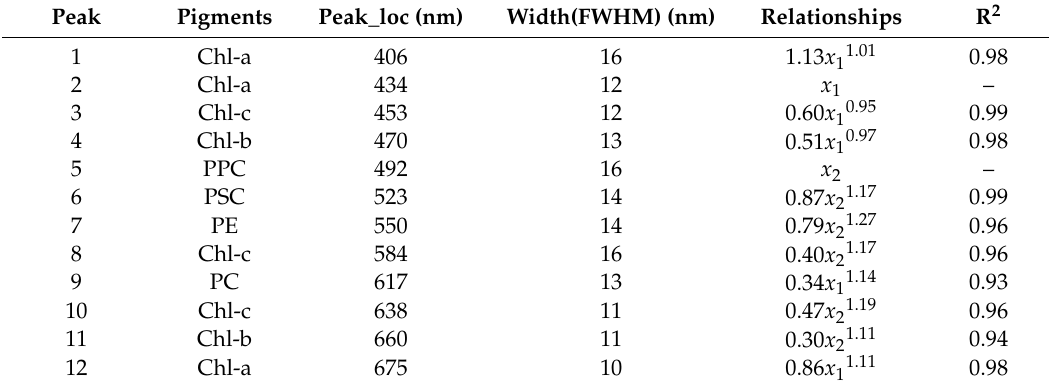
Table 2. The 12 Gaussian curves corresponding to the phytoplankton pigment absorption coefficients, with Peak_loc as the center location of each pigment absorption peak and width as the full width at half maximum (FWHM). The relationships indicate the power-law relationships used to estimate the Gaussian peak amplitudes from the two independent variables: x 1 : a Gau (434) and x 2 : a Gau (492). Chl-a: chlorophyll a , Chl-b: chlorophyll b , Chl-c: chlorophyll c , PPC: photo-protective carotenoids, PSC: photosynthetic carotenoids, PE: phycoerythrin and PC: